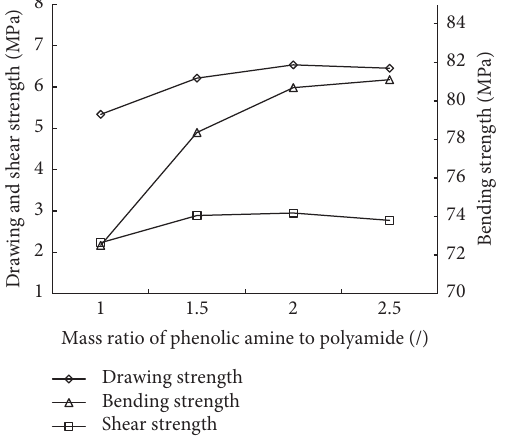
Figure 5: Mass ratio of phenolic amine to polyamide.